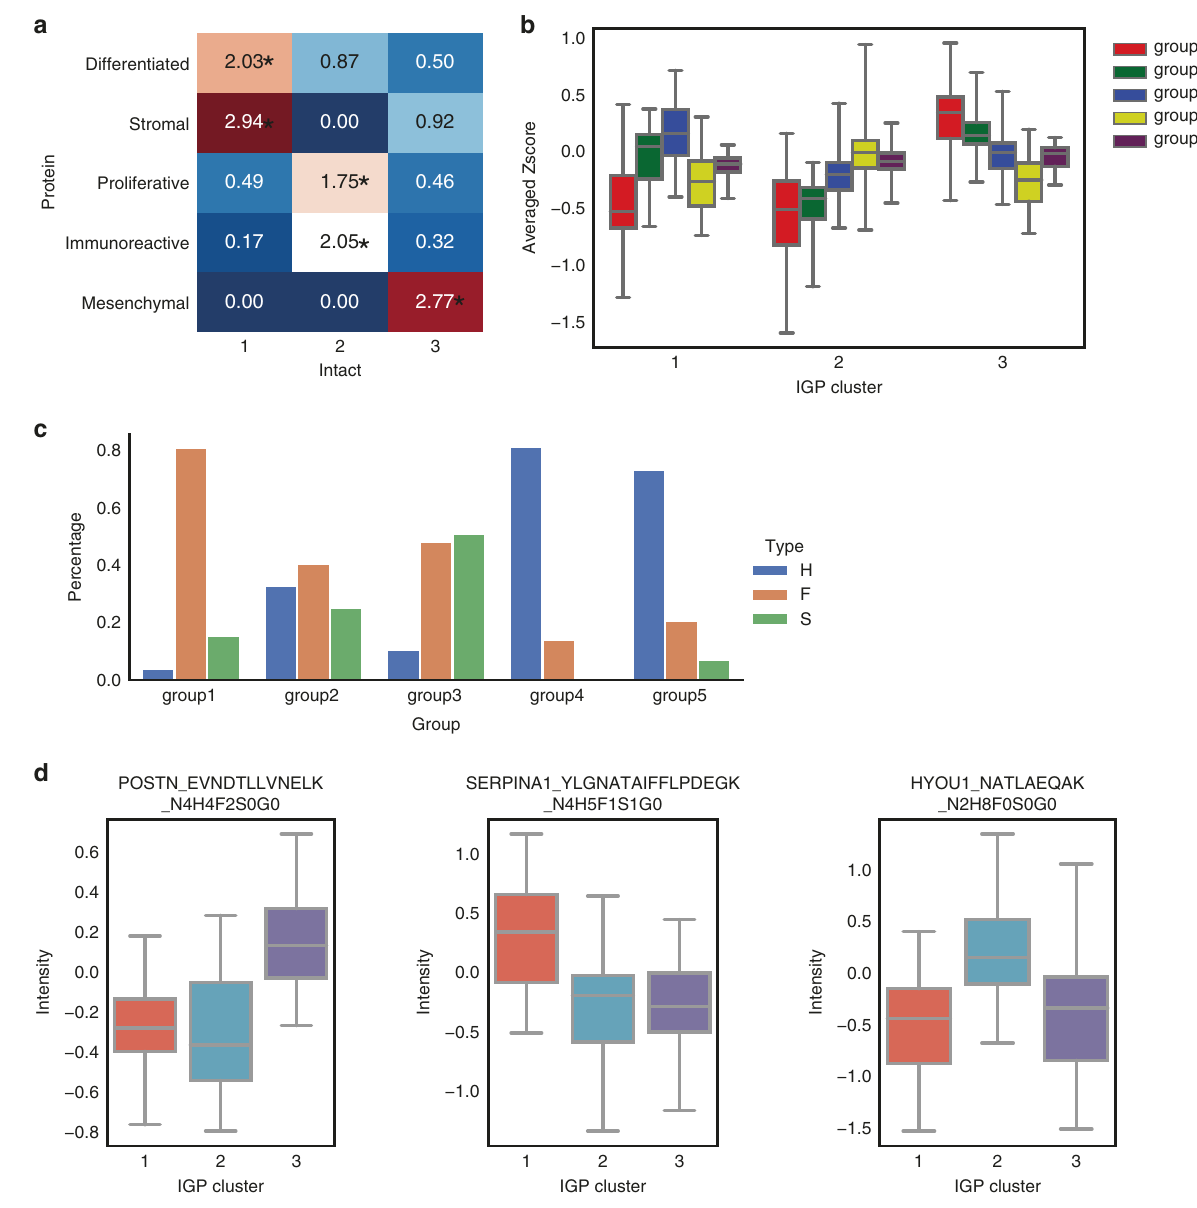
Fig. 2 Speci fi city of intact glycopeptides and glycans in tumor clusters. a Correspondence of intact glycopeptides and proteomics clusters. Values correspond to the square of number of subjects for each proteomic subtype that belong to a corresponding IGP cluster divided by both sample number of the proteomic subtype and sample number of the IGP cluster. * Indicates a p value <0.01 based on a hypergeometric test. b Averaged Z score of each group of intact glycopeptides. For every group in IGP cluster 1, n = 27 samples; for every group in IGP cluster 2, n = 49 samples; for every group in IGP cluster 3, n = 43 samples. The box outlines denote the IQR, the solid line in the box denotes median “ averaged Z score ” , and the whiskers outside of the box extend to the minimum and maximum “ averaged Z score ” . c The glycans for each IGP group. d Three examples show the different expressions in different tumor clusters. In IGP cluster 1, n = 27 samples; in IGP cluster 2, n = 49 samples; in IGP cluster 3, n = 43 samples. The box outlines denote the IQR, the solid line in the box denotes median intensity, and the whiskers outside of the box extend to the minimum and maximum intensities. Source data are provided as a Source data fi